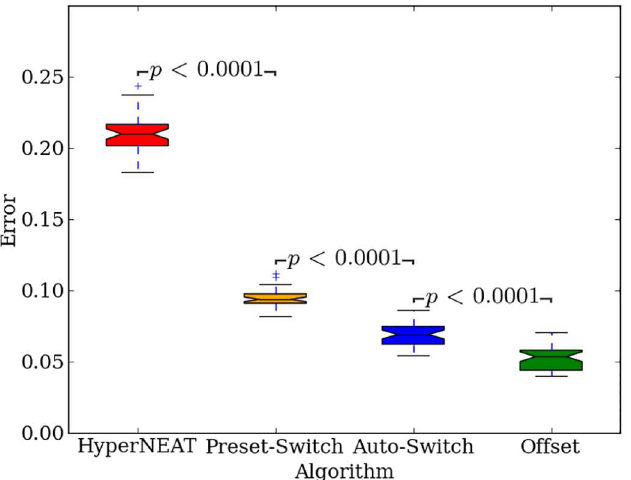
Fig 7. The performance of all methods on the target weights experiment. The mean error of generation championsfrom the target weightsexperiment(performance) averagedover all 2,000 generationsand pooled across all regularities ( n = 440) (lower is better). In this and similar plots throughoutthe paper, each colored box is boundedby the lower and upper quartilevalues, with a line at the median.The whiskersshow the range of the data, while the box notches are proportional to the interquartile range and are calculatedusing the default matplotlib function.